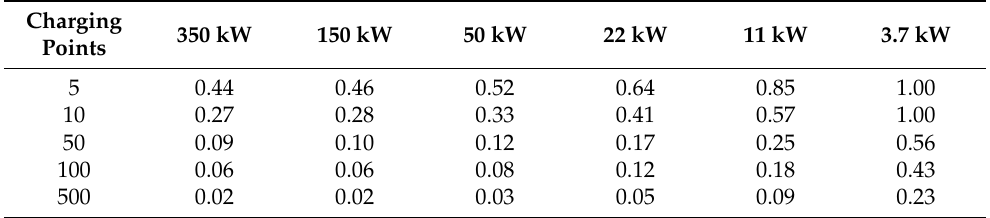
Table A1. Demand factors for the area type “Urban Region: Metropolis” and six charging powers.